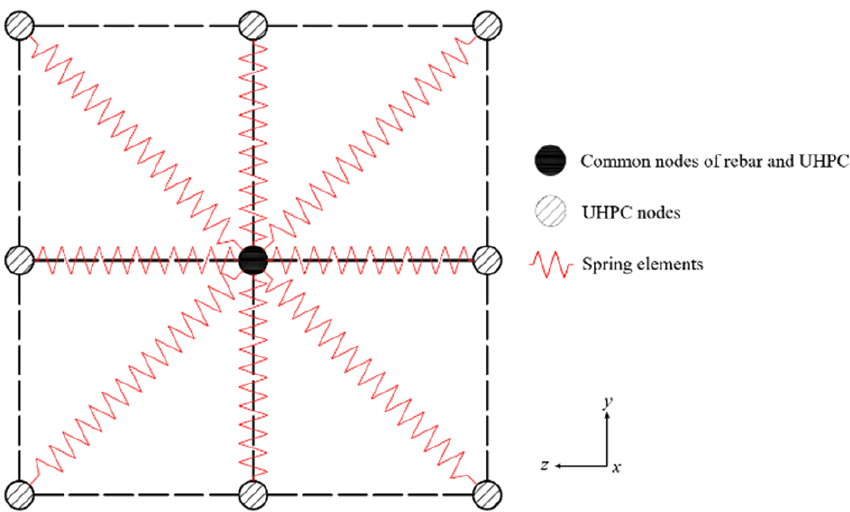
Figure 10. Spring constraint schematic diagram.